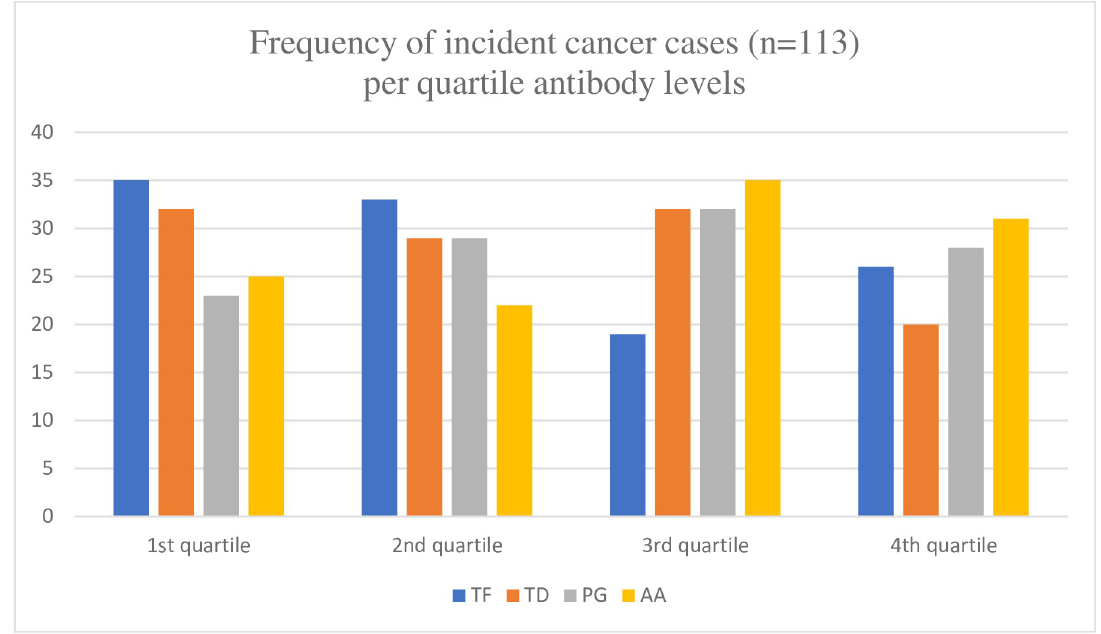
Fig 3. Frequency of incident cancer cases (n = 113) per quartile antibody levels of the oral bacteria Tannerella forsythia (TF), Porphyromonas gingivalis (PG), Treponema denticola (TD) and Aggregatibacter actinomycetemcomitans (AA). Quartile (Q) levels: TF Q1 1–28, Q2 29–44, Q3 45–73, Q4 74–1240, TD Q1 1–28, Q2 29–44, Q3 45–73, Q4 74–1240, PG Q1 1–28, Q2 29–44, Q3 45–73,